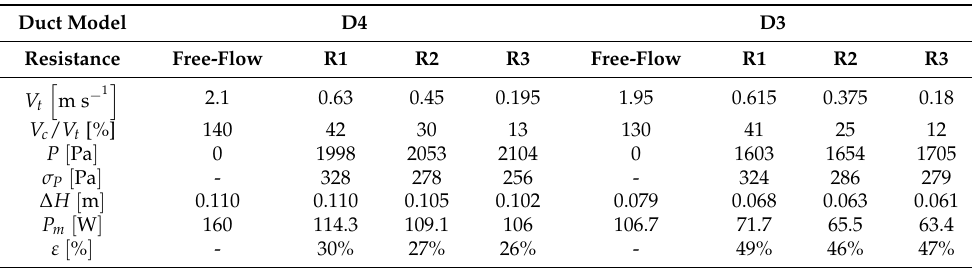
Table 1. The effects of P , V t / V c , ∆ H , and P m on free-flow and partial obstruction for Models D3 and D4, with V c = 1.5 m s − 1